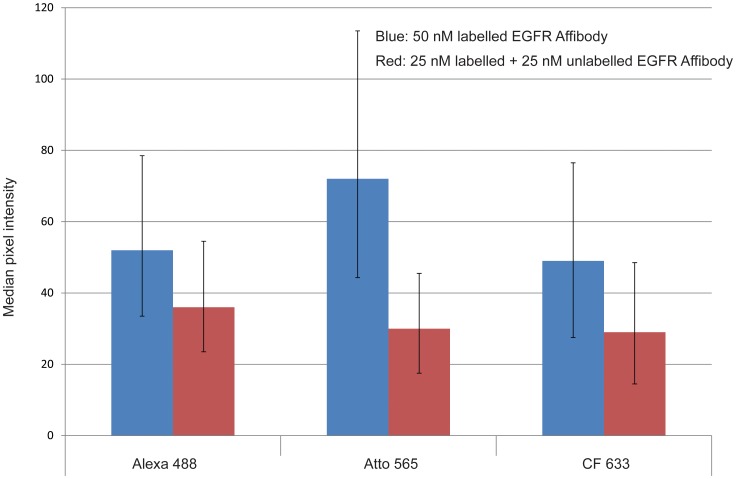
Fluorescence intensity measured from confocal microscopy images of T47D cells labeled with 50-conjugated EGFR affibody, and a mixture of 25 nM dye-conjugated affibody and 25 nM unlabeled affibody.Three dyes were selected to cover the range of mobilities (Alexa 488, high mobility; CF 633, moderate mobility; Atto 565, low mobility). Columns represent the median of the distribution of membrane region pixel intensities derived from at least 100 cells. Error bars represent the positions of the 1st and 3rd quartile of the distributions.